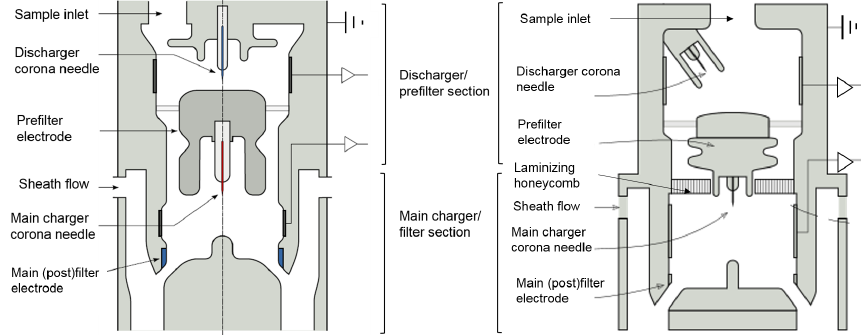
Figure 2. A cross section of the aerosol preconditioning unit and upper part of the mobility analyzer for old generation (left column) and new generation (right column) of the NAIS. Grounding of the different parts are visualized.